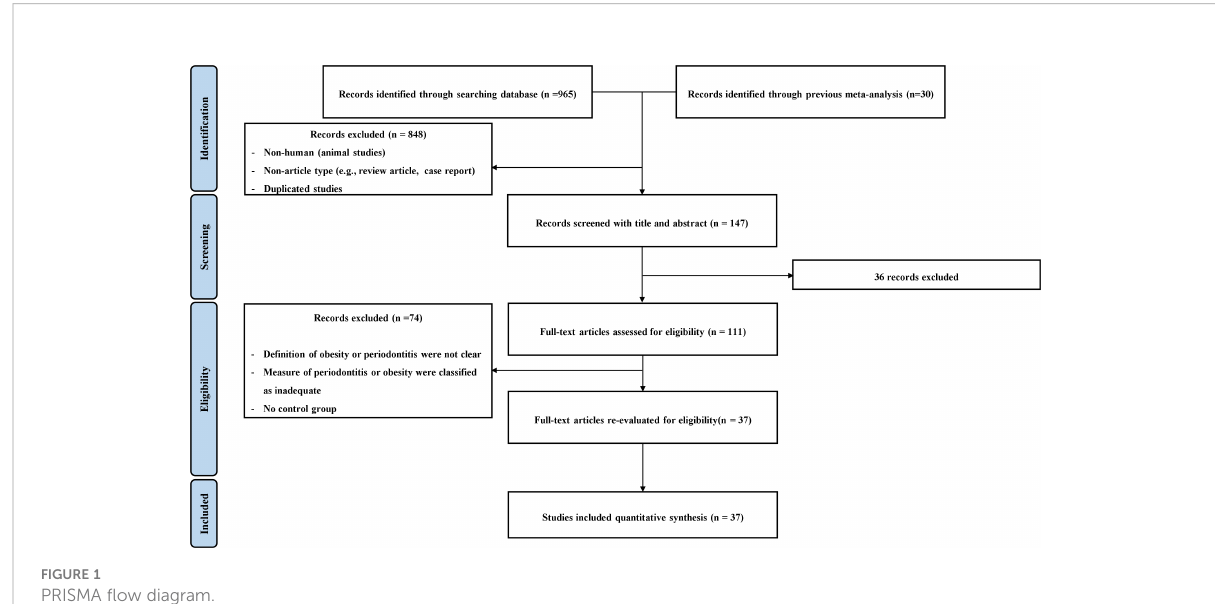
FIGURE 1 PRISMA fl ow